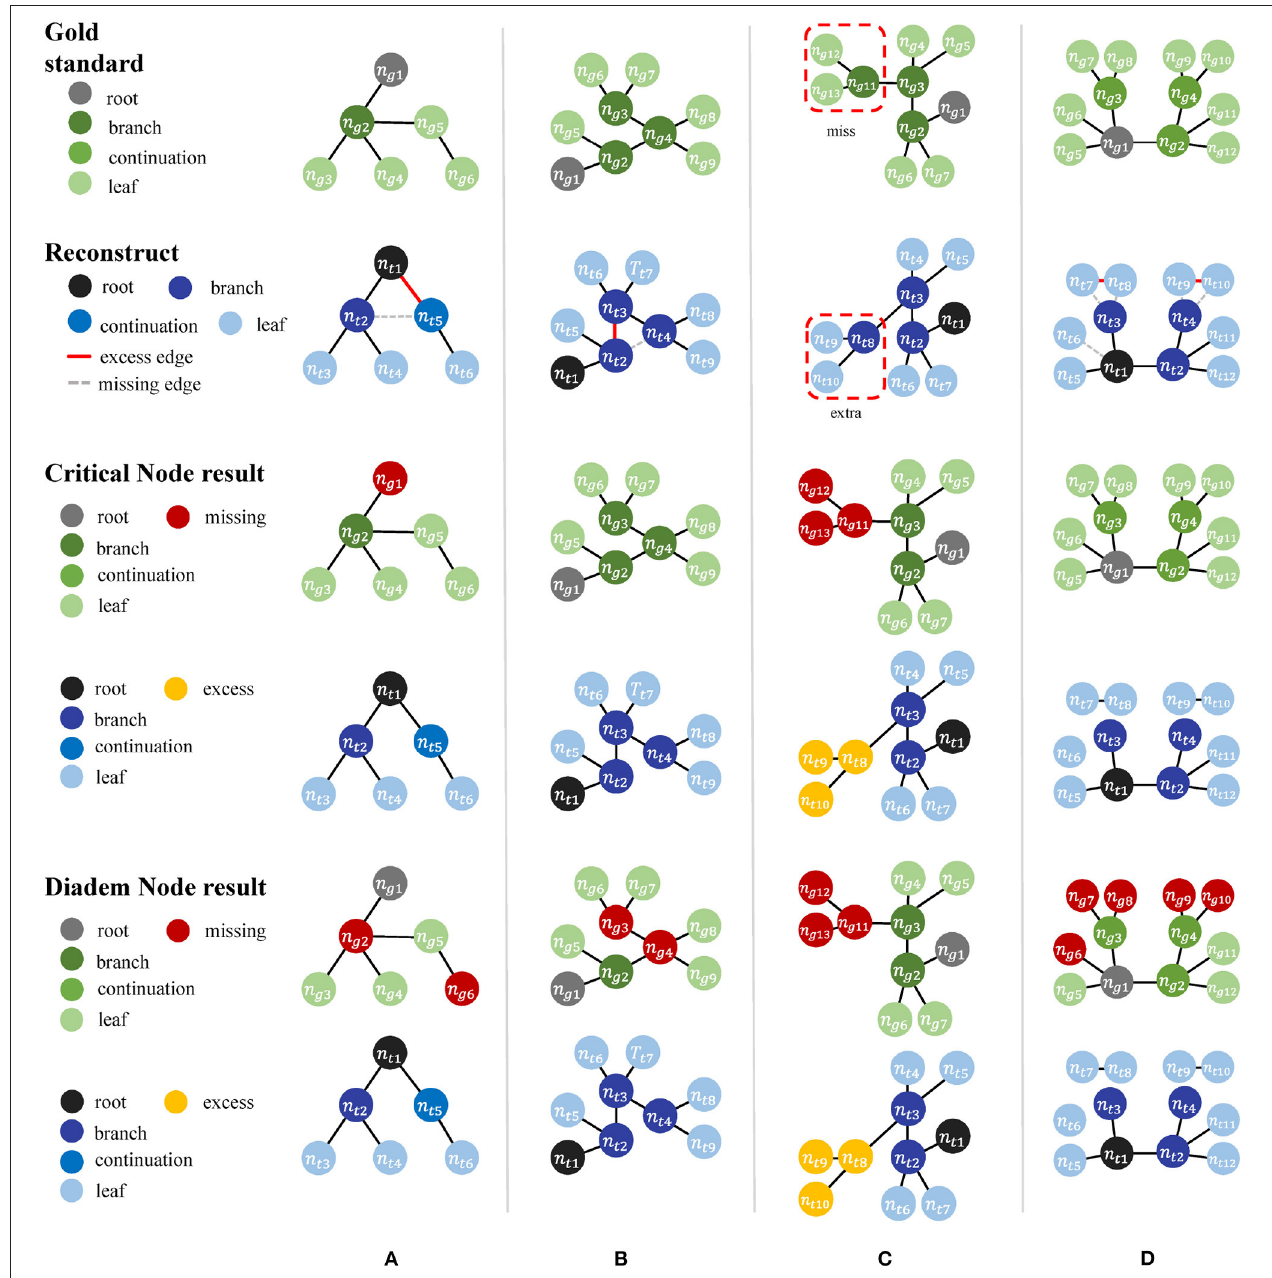
FIGURE 4 | (A–D) Four manually constructed cases for testing topological metrics.